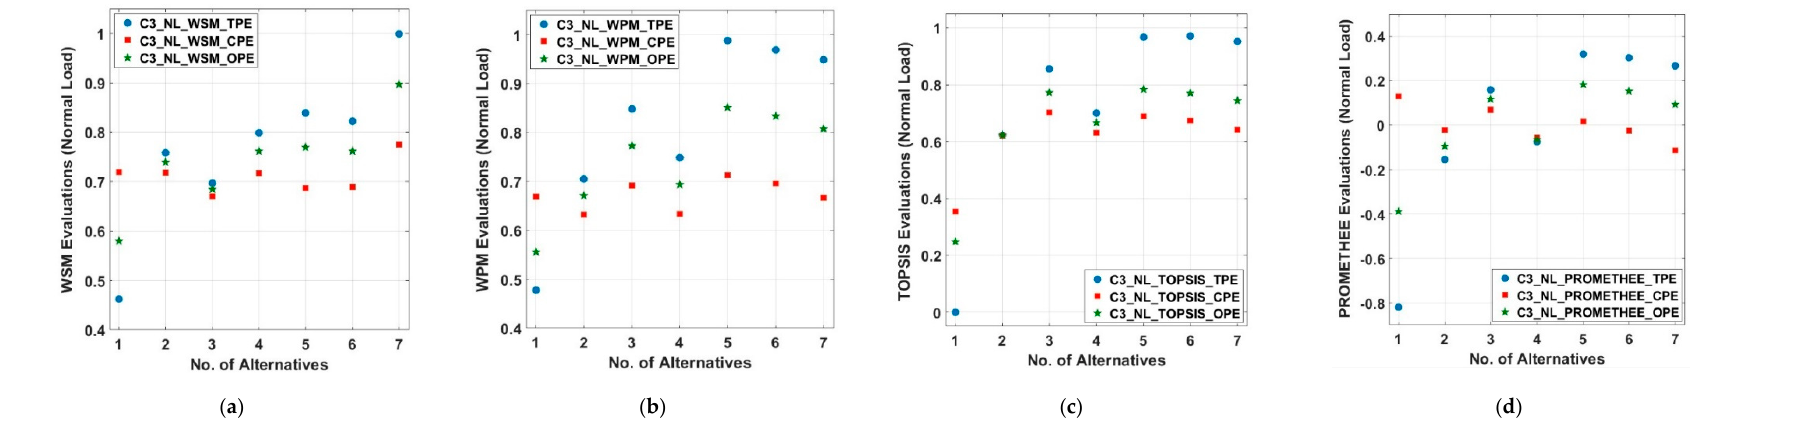
Figure 7. MCDM evaluations for C3_NL in 33-bus MDN: ( a ) WSM scores; (b) WPM scores; ( c ) TOPSIS scores; ( d ) PROMETHEE scores. Table 10. Order of the ranks across TPE, CPE, and OPE in C3_NL for 33-bus